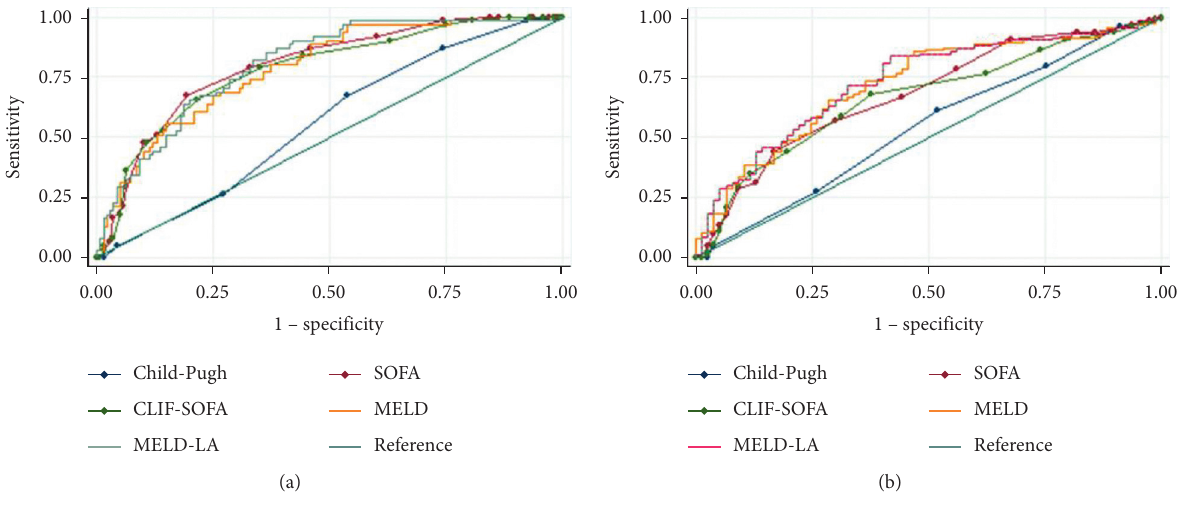
Figure 3: Receiver operating characteristic curves of the scoring systems for (a) 15-day and (b) 5-year mortality in critically ill patients with cirrhosis caused by alcohol alone. SOFA, sequential organ failure assessment; CLIF-SOFA, chronic liver failure-sequential organ failure assessment; MELD, model for end-stage liver disease; MELD-LA, model for end-stage liver